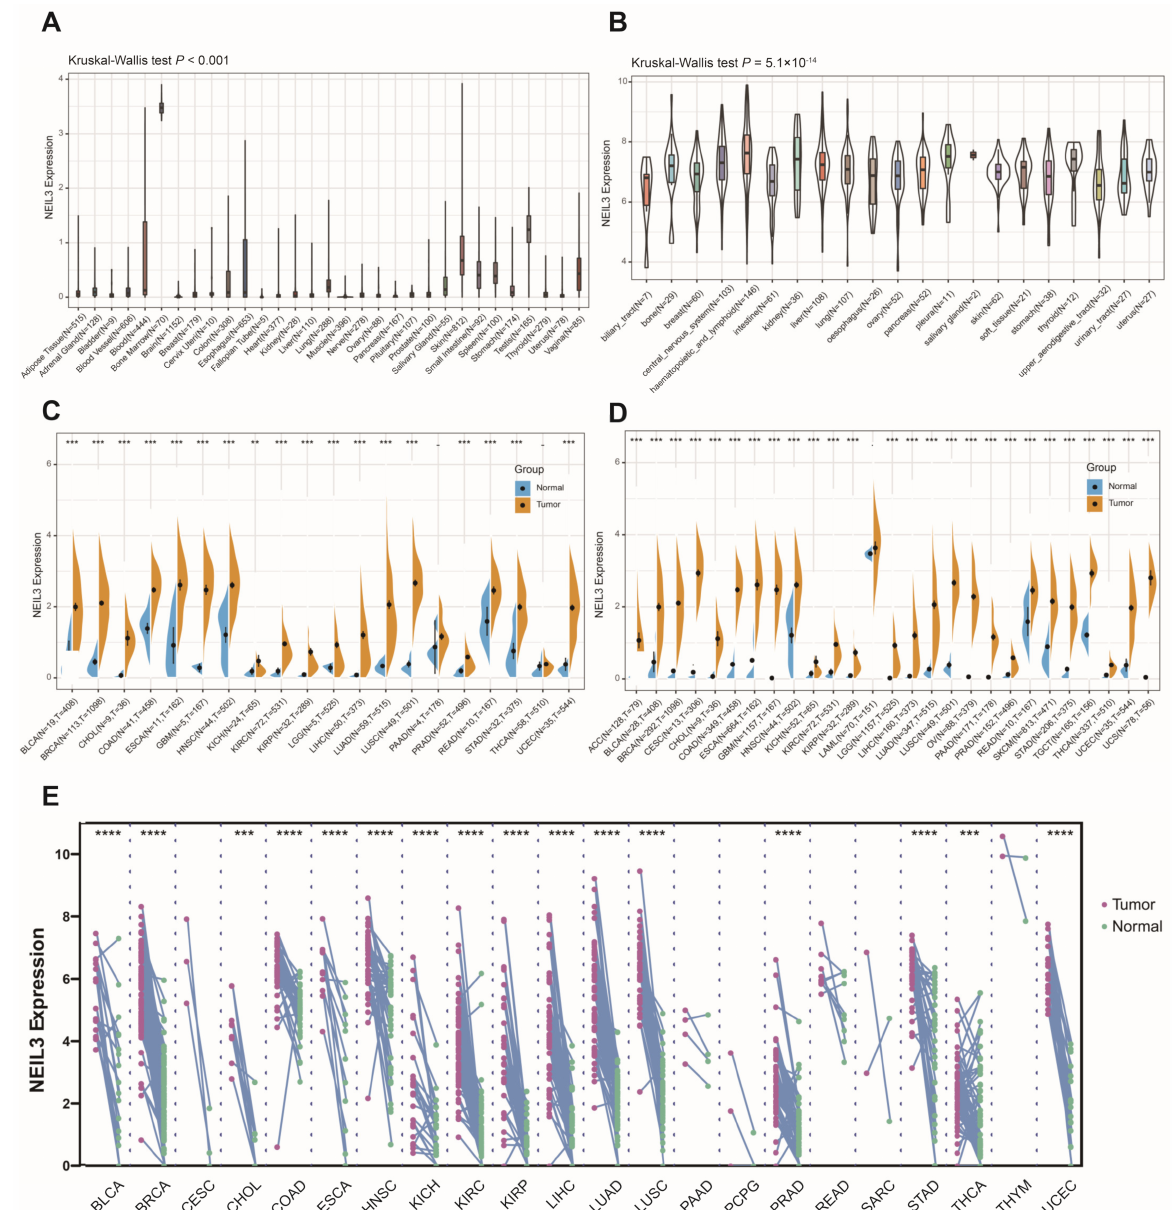
Figure 1. The mRNA expression level of NEIL3 across human cancers. The mRNA expression of NEIL3 in ( A ) 31 types of normal tissues (N, number of samples); ( B ) 21 types of cancer cell lines in CCLE database (N, number of samples); ( C ) 20 types of cancers and normal tissues in TCGA database (N, normal; T, tumor); ( D ) tumor and normal tissues in TCGA combined with GTEx database (N, normal; T, tumor); and ( E ) tumor and paired adjacent normal tissue in TCGA database. ** p < 0.01, *** p < 0.001, **** p <